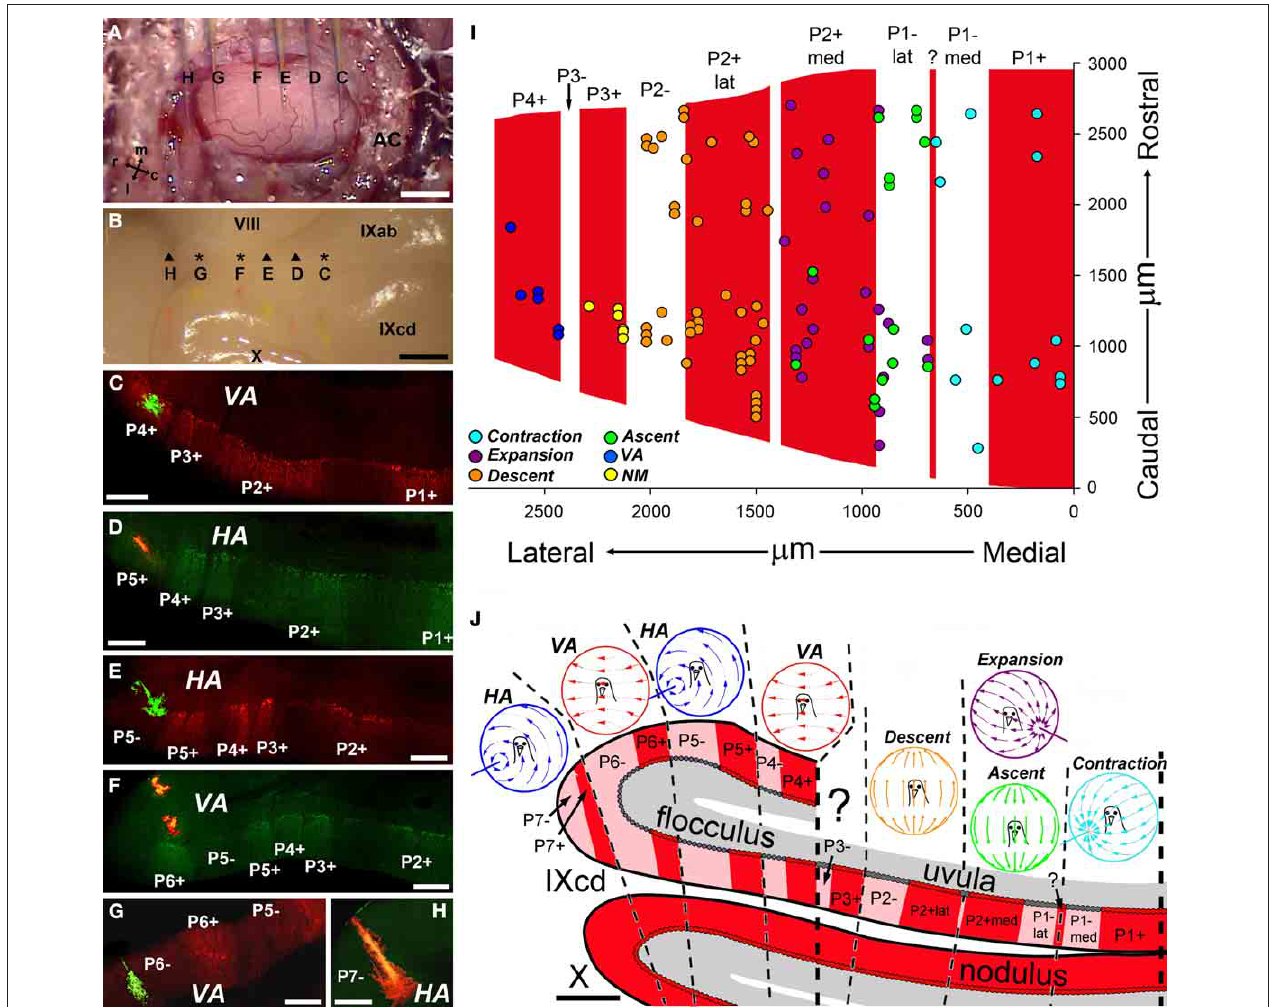
FIGURE 9 | Relationship between the optic flow zones and the zebrin II (ZII) stripes in the pigeon vestibulocerebellum (VbC). (A–H) Show results from a single experiment. (A) Shows the surface of the exposed flocculus. This is the superimposition of six photos, such that the locations of six injection electrodes (C–H) filled with either red biotinylated dextran amine (BDA) (D,F,H) or green BDA (C,E,G) are shown. (B) Shows the subsequently perfused and dissected brain. Traces of the six injections can clearly be seen on the surface of IXcd. (C–H) Show coronal sections through the VbC that have been immunoreacted for ZII to illustrate the locations of all the injections in particular ZII stripes (from Pakan et al., 2011). (I) Shows our efforts to